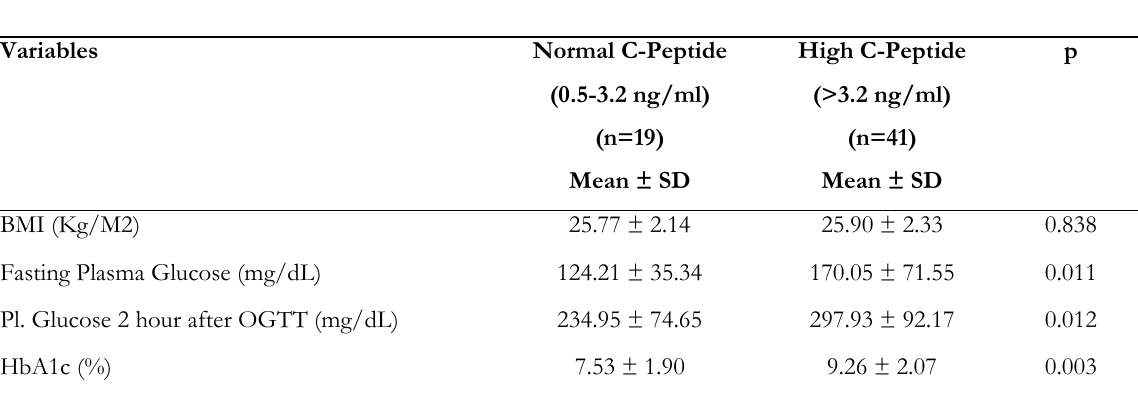
Table 2. Comparison of BMI, fasting plasma glucose, plasma glucose 2hrs after OGTT, and HbA1c between T2DM subjects with normal and high